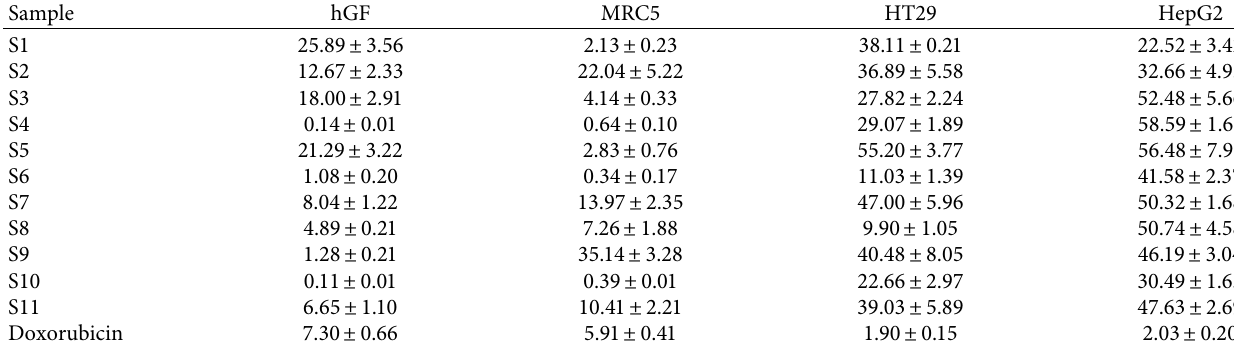
Table 3: Cytotoxic effect of the eleven SLT extracts and doxorubicin against the human gingival fibroblasts, normal lung fibroblast, colon